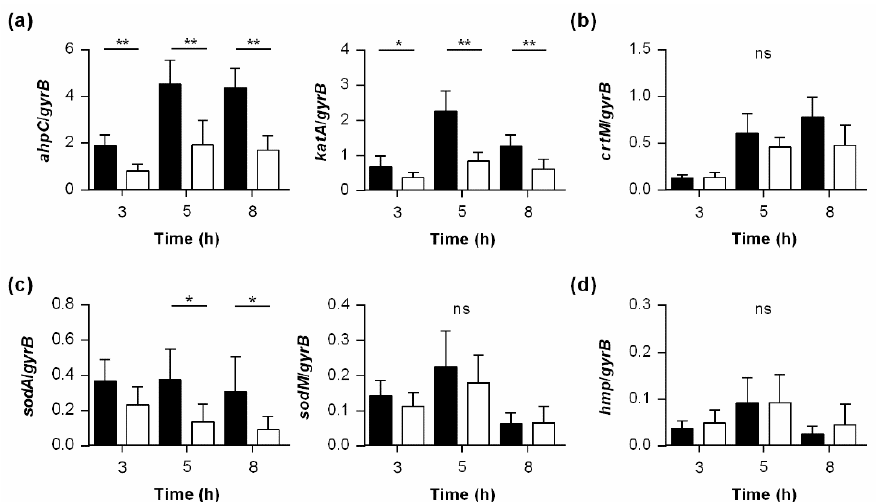
Figure 7. Effect of a ptpB deletion on the transcription of genes encoding enzymes involved in the detoxification of ROS in S. aureus . Quantitative transcript analyses of ahpC and katA ( a ), crtM ( b ), sodA and sodM ( c ), and hmp ( d ) by qRT-PCR in SA564 (black bars) and SA564 Δ ptpB (white bars) cells grown in TSB at 37 °C and 225 rpm to the time points indicated. Transcripts were quantified in reference to the transcription of gyrase B (in copies per copy of gyrB ). Data are presented as mean + SD of five biological replicates. * p < 0.05; ** p < 0.01 (Mann-Whitney U test between WT and mutant at a given time point).